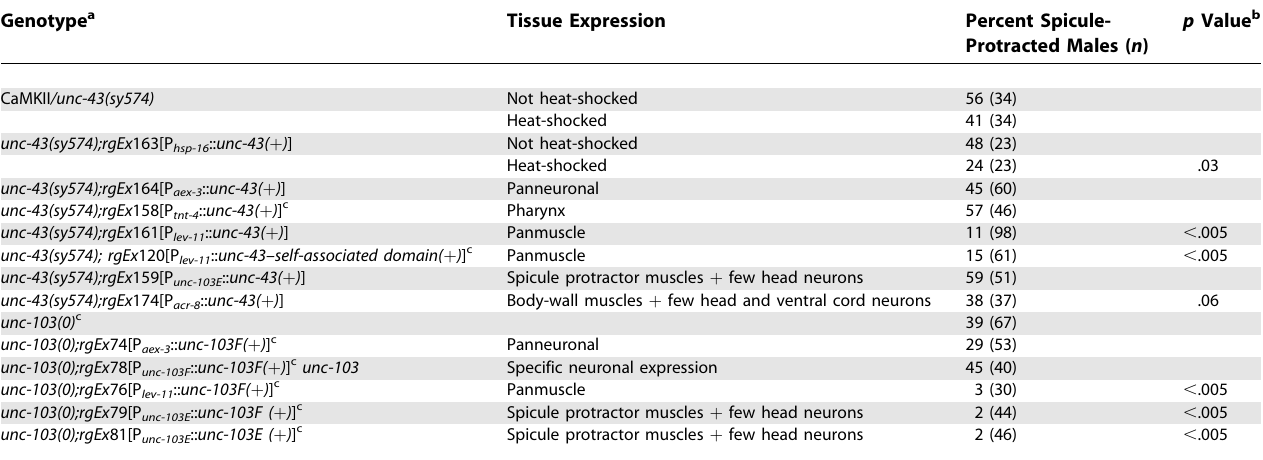
Table 3. Transgenic Rescue of Mutant CaMKII/ unc-43 and ERG-like K þ channel/ unc-103 –Induced Spicule Protraction Genotype a Tissue